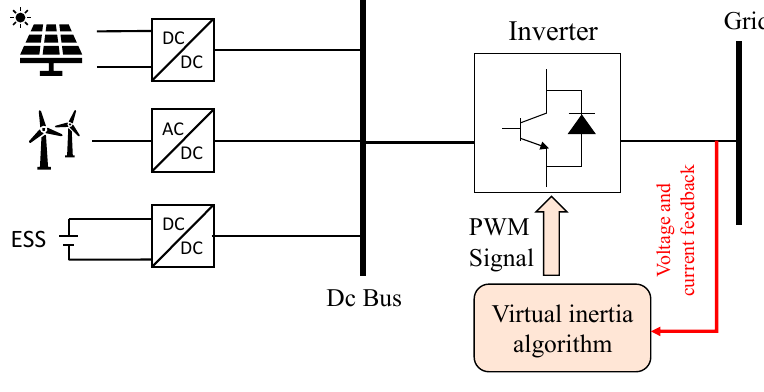
Figure 3. Concept of virtual inertia [18].